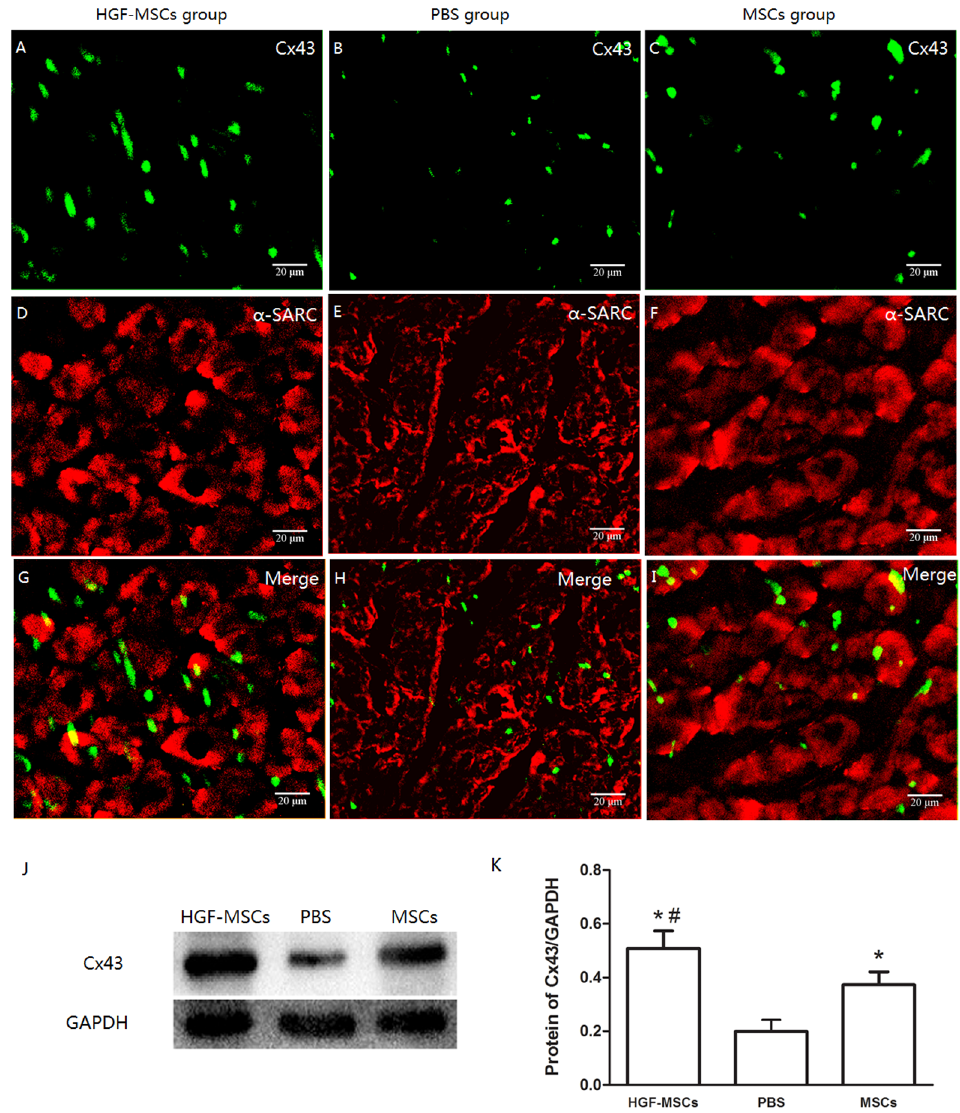
Figure 5. Electrical remodeling. (A–I) The myocardial infarction-induced disturbance of Cx43 expression, including lateralization and a reduction in area, was significantly restored and ameliorated, respectively, by HGF-MSC transplantation. MSC engraftment resulted in a similar but significantly weaker effect. (J–K) Cx43 expression levels were compared between the groups via western blot analysis. *, P , 0.01 vs. the PBS group; # , P , 0.01 vs. the MSC